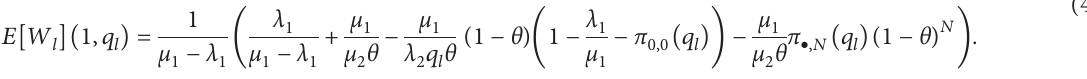
q e . (a) E [ W l ] vs. q l ( q e h